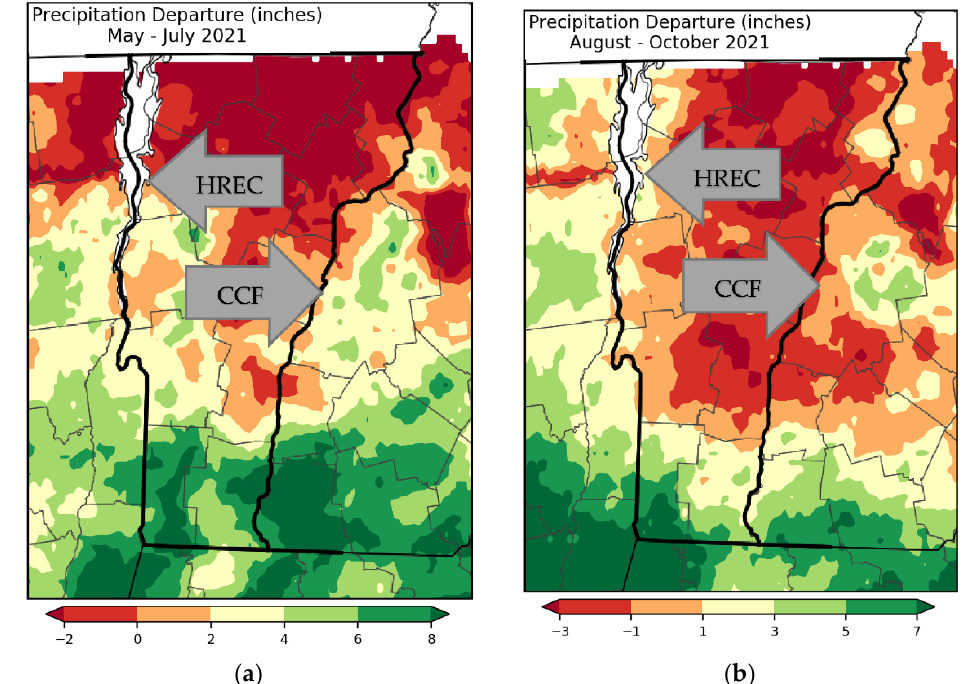
Figure 1. Accumulated precipitation departure from historic 30-year mean. Reprinted/adapted with permission from Northeast Regional Climate Center [37]. 1 inch = 25.4 mm. ( a ) Accumulated precipitation departure from normal in Vermont, May–July, 2021. ( b ) Accumulated precipitation departure from normal in Vermont, August–October, 2021.